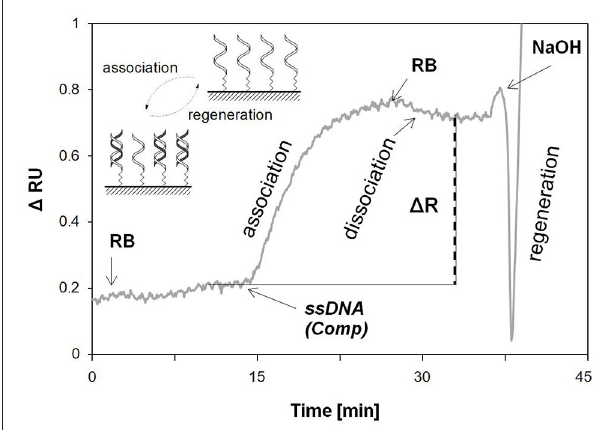
FIGURE 2 | Exemplary, real-time results of DNA-DTC probe hybridization with complementary sequence ( Comp , C DNA = 50nM) . Differential sensogram was registered for single family of SPRi spots. Particular stages of the SPR experiment and the way of quantitative interpretation of the sensor’s response are indicated.